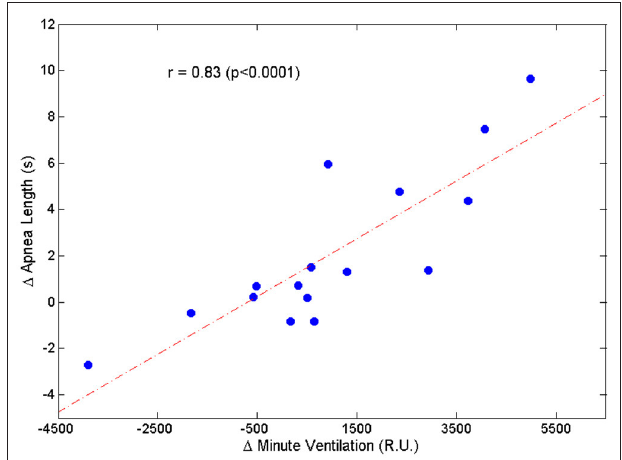
FIGURE 7 | Relationship between the change in apnea length ( 1 Apnea Length = average difference between the length of apneas preceded by a hyperpnea with arousal and the length of apneas preceded by a hyperpnea without arousal) and the corresponding change in mean ventilation ( 1 Minute Ventilation = average difference between mean ventilation of hyperpneas with arousal and mean ventilation of hyperpneas without